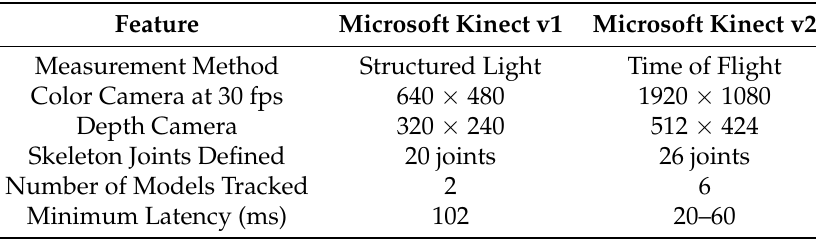
Table 1. Specifications of the two Kinect